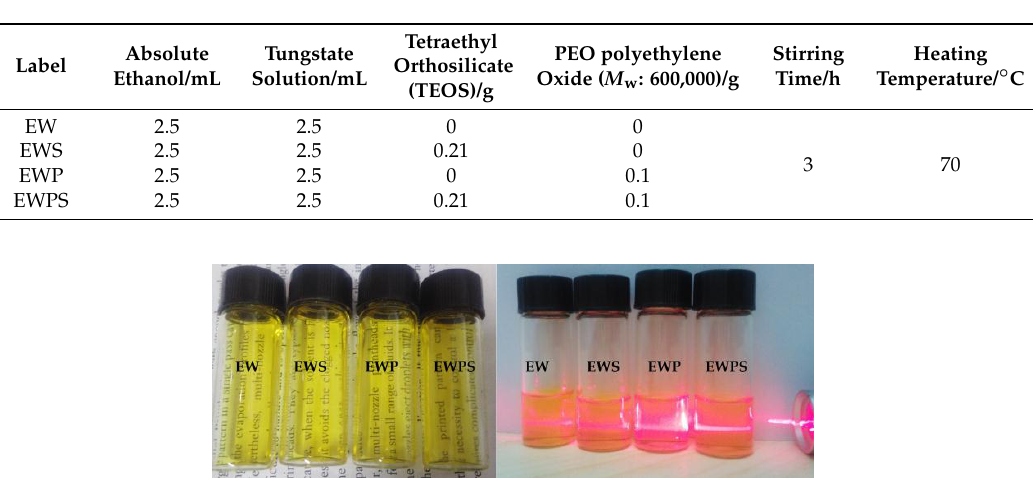
Table 1. The parameters of four kinds of solution. EW, control solution, pure tungstate solution; EWS, EWP, EWPS, experimental solutions (with SiO 2 , PEO, SiO 2 and PEO, respectively).